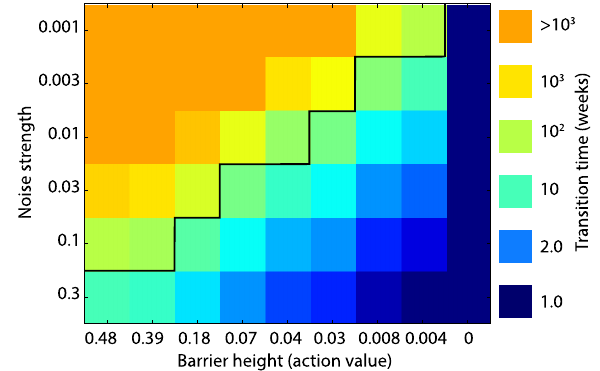
FIG. 5. Transition time for the cell death model as a function of barrier height and noise strength. Transition time is calculated using Eq. (6). The black line separates those barrier height – noise strength combinations that occur over a therapeutically relevant time scale (bottom right) and those that do not (top